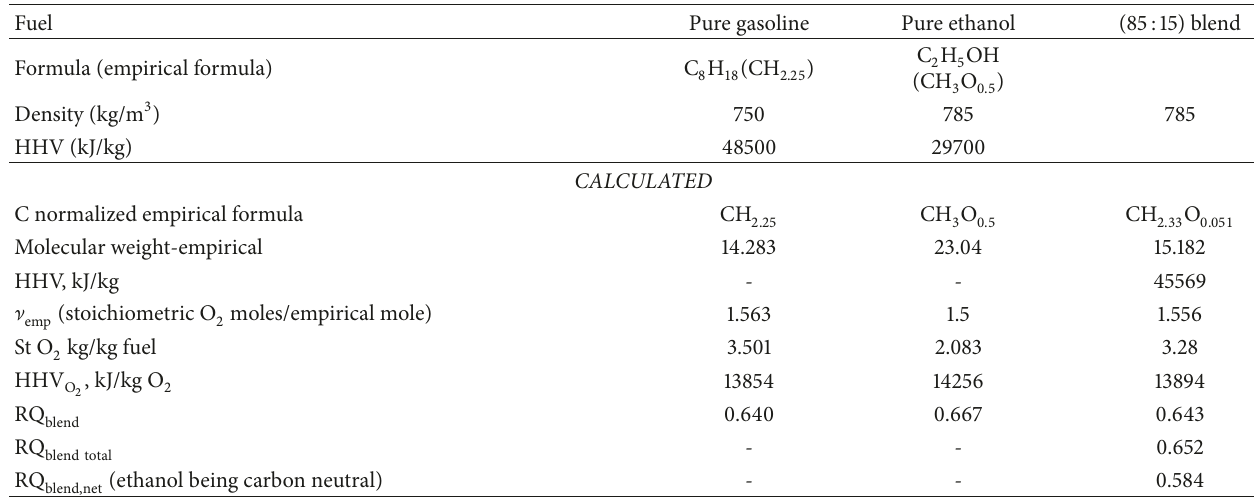
= 0.09 ; RQ = RQ + RQ ; process , ethanol Blend , total Blend process , ethanol